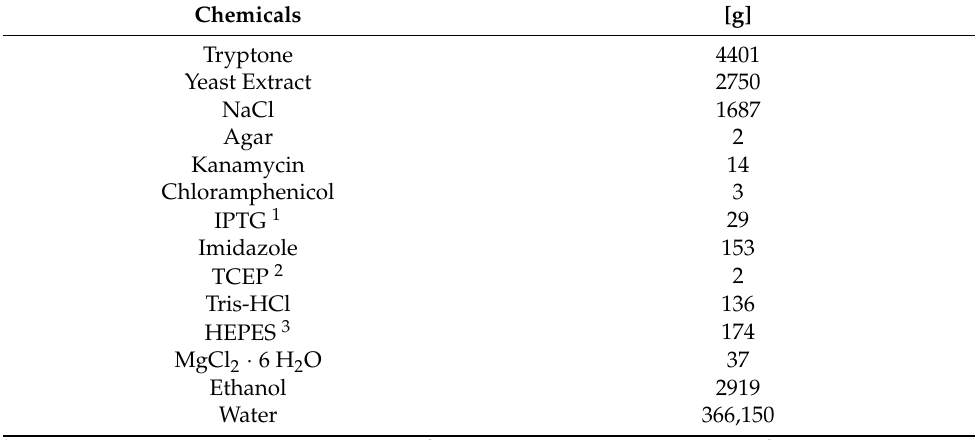
Table 1. List of all chemicals required for the production and purification of 10 g enzyme. For this purpose, the model enzyme cGAS was synthesized in E. coli BL21 (DE3) pLysS in 2xYT (yeast extract trypton) medium and subsequently purified by cell disruption, centrifugation, affinity chromatogra- phy, and buffer exchange.